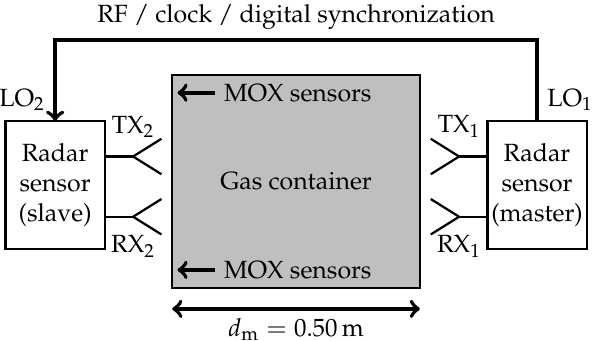
Figure 4. Schematic illustration of the measurement setup, showing the gas container, antennas and metal oxide (MOX) sensor mounting positions. Two synchronized, bi-static radar sensors are placed on opposing sides, transmitter and receiver of the master MMIC are connected to antennas TX 1 and RX 1 , for the slave MMIC to TX 2 and RX 2 , respectively. RF, clock and digital synchronization signals are forwarded from master to slave sensor via a waveguide and cables. When configured for the VNA reference measurement, the radar sensors are replaced by mono-static VNA ports connected to antennas TX 1 and TX 2 , while antennas RX 1 and RX 2 as well as the synchronization link are not in